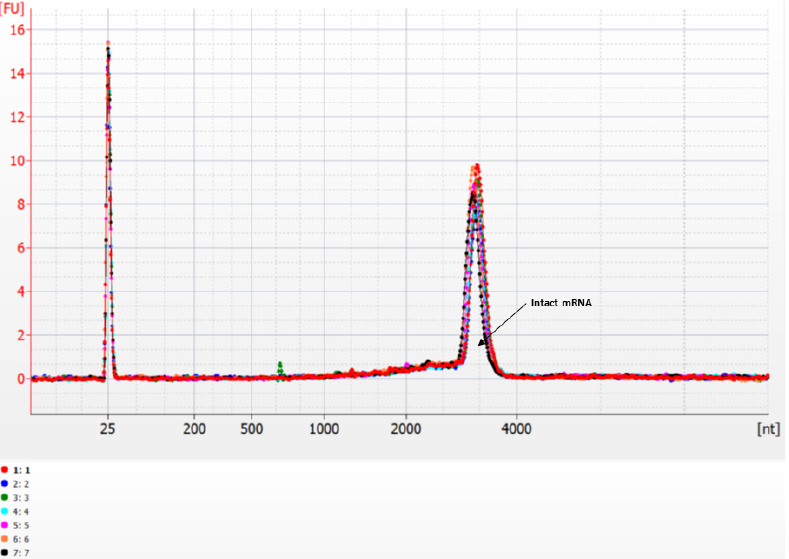
Figure 1. Analysis of mRNA integrity of reconstituted Moderna COVID-19 vaccines. Representative electropherograms expressed in fluorescence units (FU) of RNA integrity for 7 superposed different mRNA samples detailing the regions that indicate intact mRNA peaks in the analyzed samples.